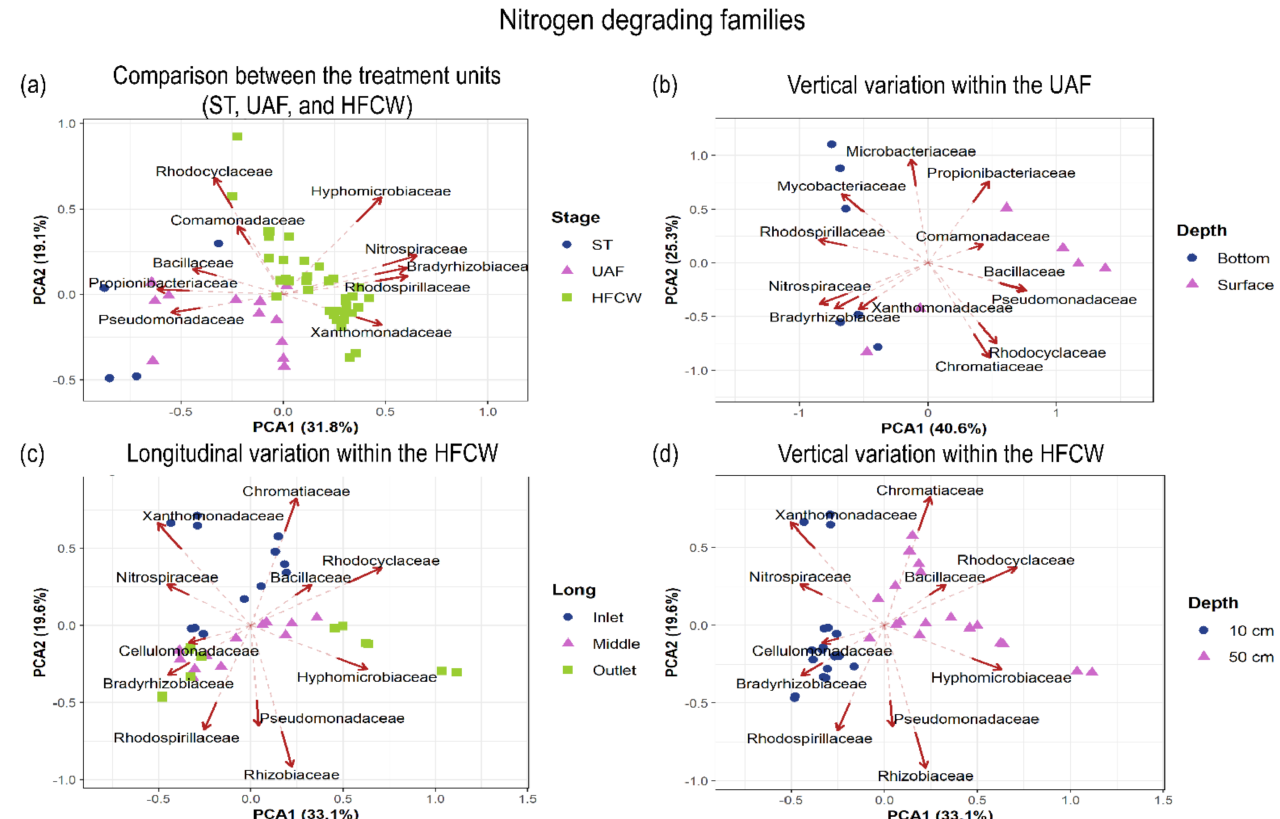
Figure 6. Biplots for nitrogen degrading bacterial families ( a ) Comparison between the treatment units (ST, UAF, and HFCW), ( b ) Vertical variation within the UAF. ( c ) Longitudinal variation within the HFCW ( d ) Vertical variation within the HFCW. For illustration purposes, only the families that appear in the discussion are